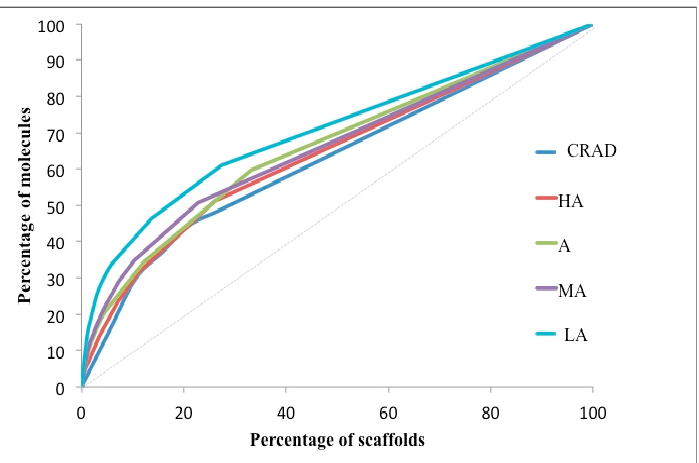
Figure 3. Cumulative Scaffold Frequency Plots of Level 1 scaffold of datasets. Plots for currently registered antimalarial drugs (CRAD), natural products with in vitro antiplasmodial activity (NAA) subgroups: HA-highly active, A-active, MA-moderately active and LA-low active are shown. The closer the curve is to the diagonal line, the greater the scaffold diversity of the data set. The low